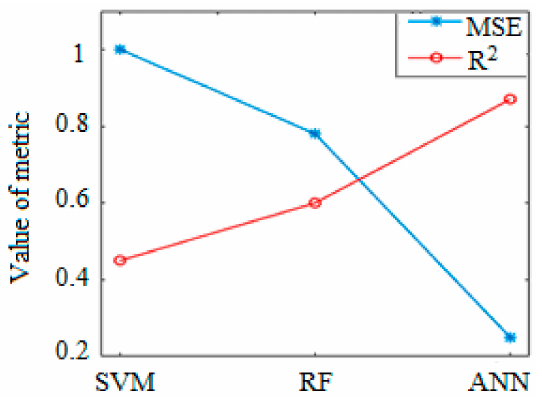
Figure 8. Comparison of R 2 and MSE values of all the ML models.